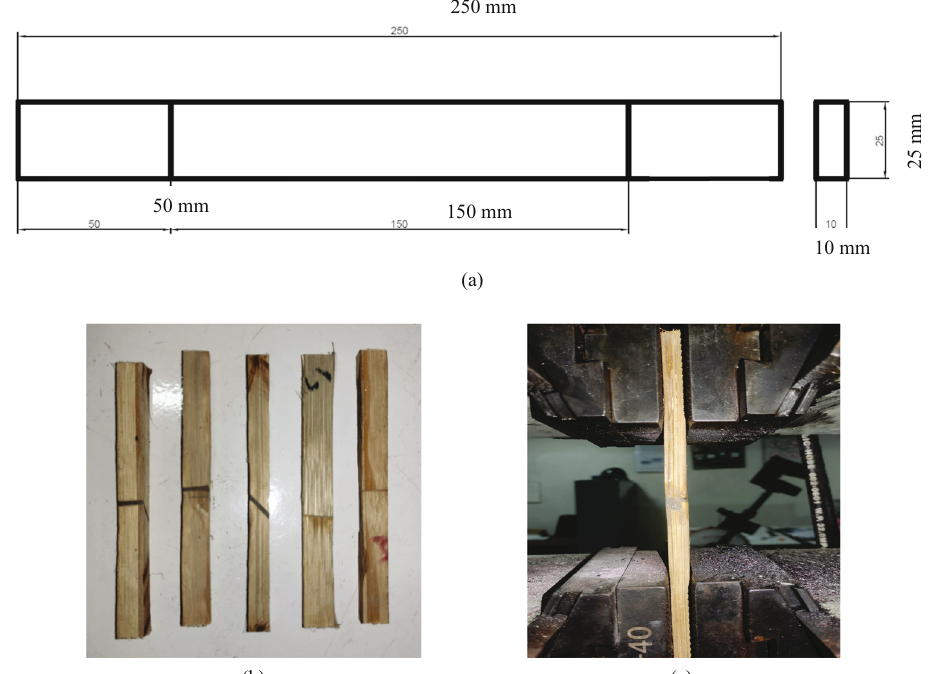
Figure 6: ( a ) Specimen size based on ASTM D - 3039, ( b ) tensile test specimen, and ( c ) Universal Testing Machine ( UTM ) WEW - 1000B.